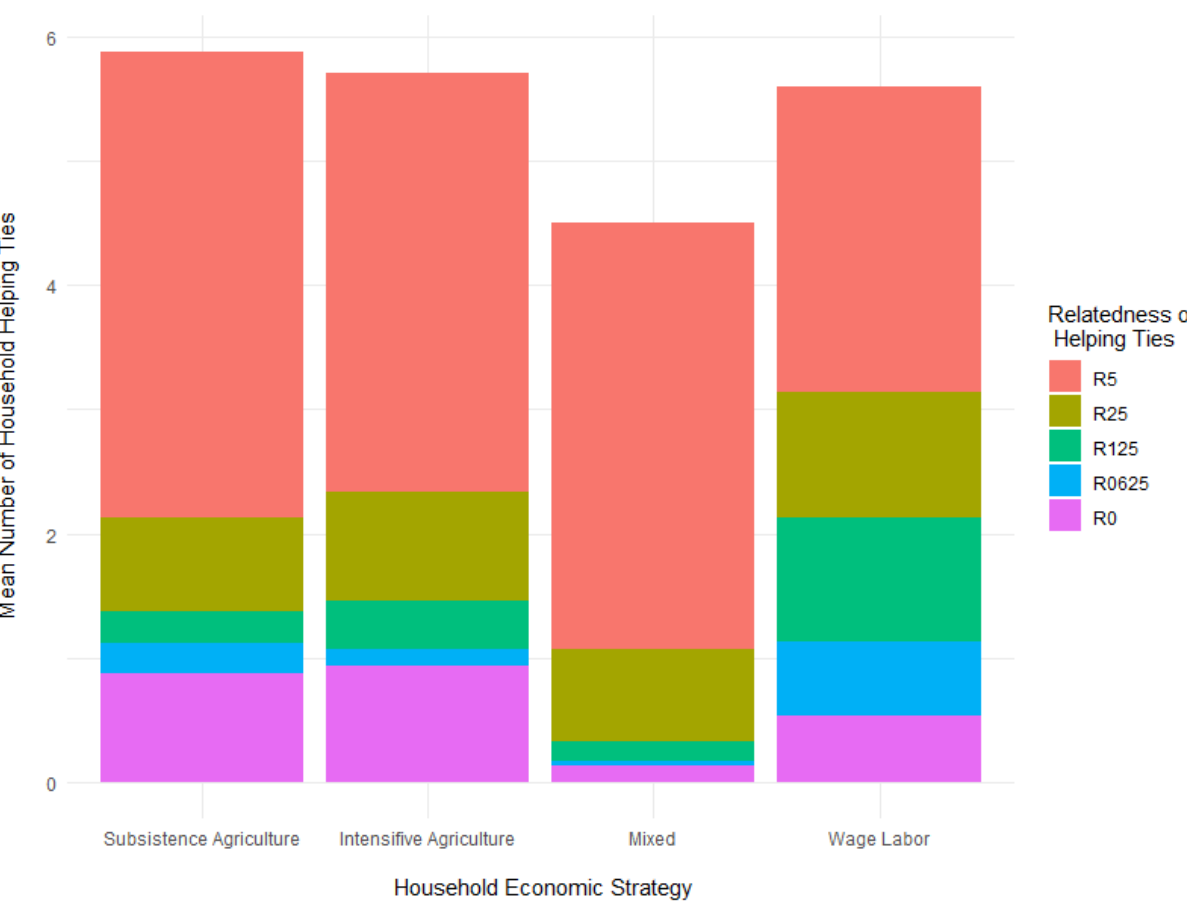
Figure 3. Kin composition of between household support ties. Table 2. Social Relations Model Results.